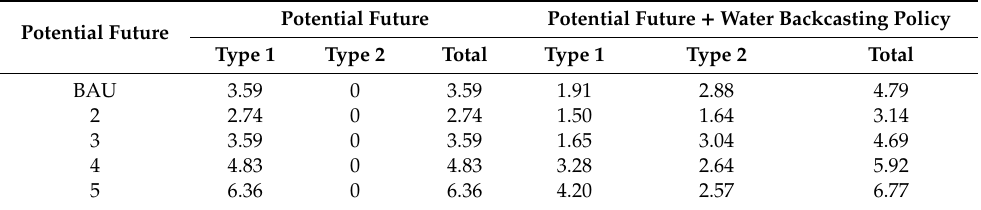
Table 11. Proportion (%) of WP CSA that is in bu ff er zone type 1 (scrub) and type 2 (Continuous Cover Forestry (CCF)) by the end of the planning horizon in each potential future, and as a result of implementing the Water backcasting